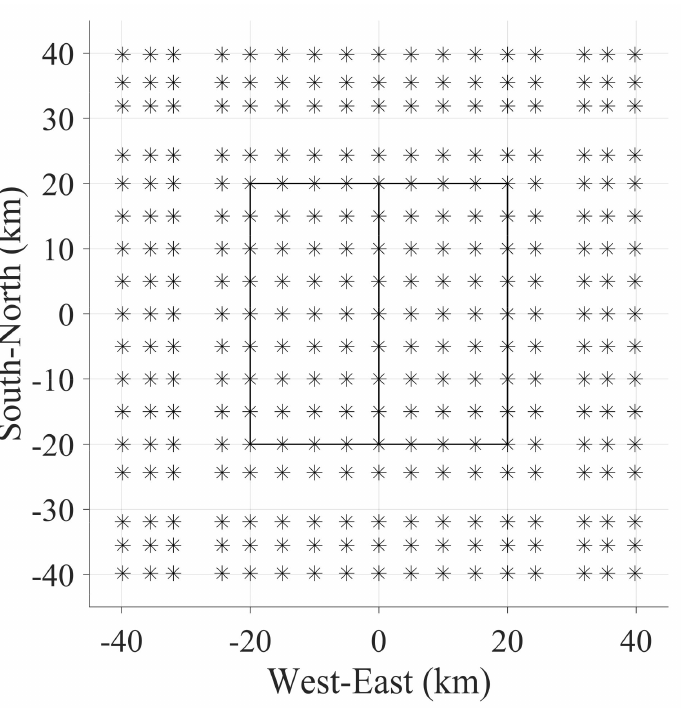
Figure 15. Observed sites distributed on the plan view of COMMEMI 3D-2A model. The * symbols de- note the observed sites. The rectangles are the projection of anomalous prisms on the Earth’s surface.